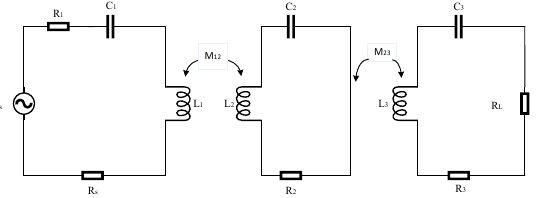
Figure 8. Three-coil magnetic coupling resonant wireless power transmission system circuit model.